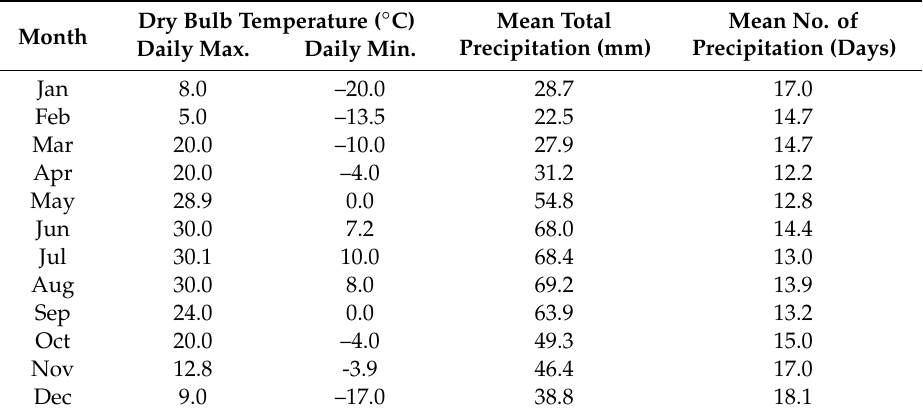
Figure 2. Case study building location map with its surroundings. Table 1. Monthly statistics for dry bulb temperatures for case study and